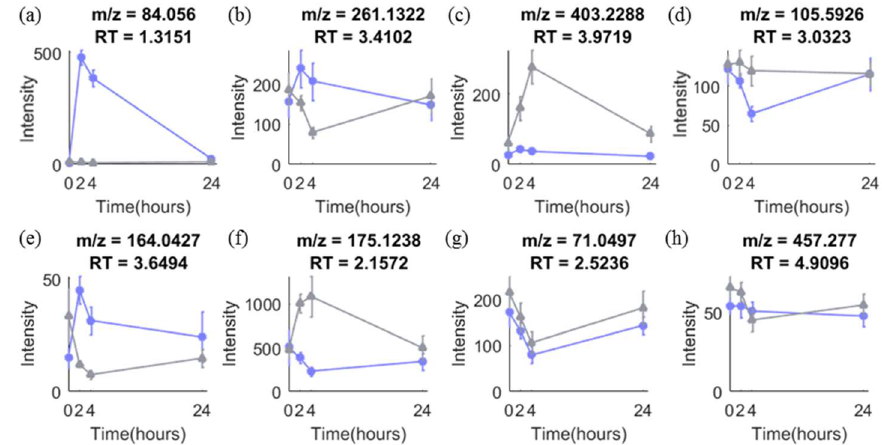
Figure 1. Typical temporal profiles of metabolites observed in metabolomics data from our onion study with a time-series design. ( a )–( h ) are temporal profiles of eight metabolites in control (grey) and intervention (purple) group. More details are explained in Text S1.